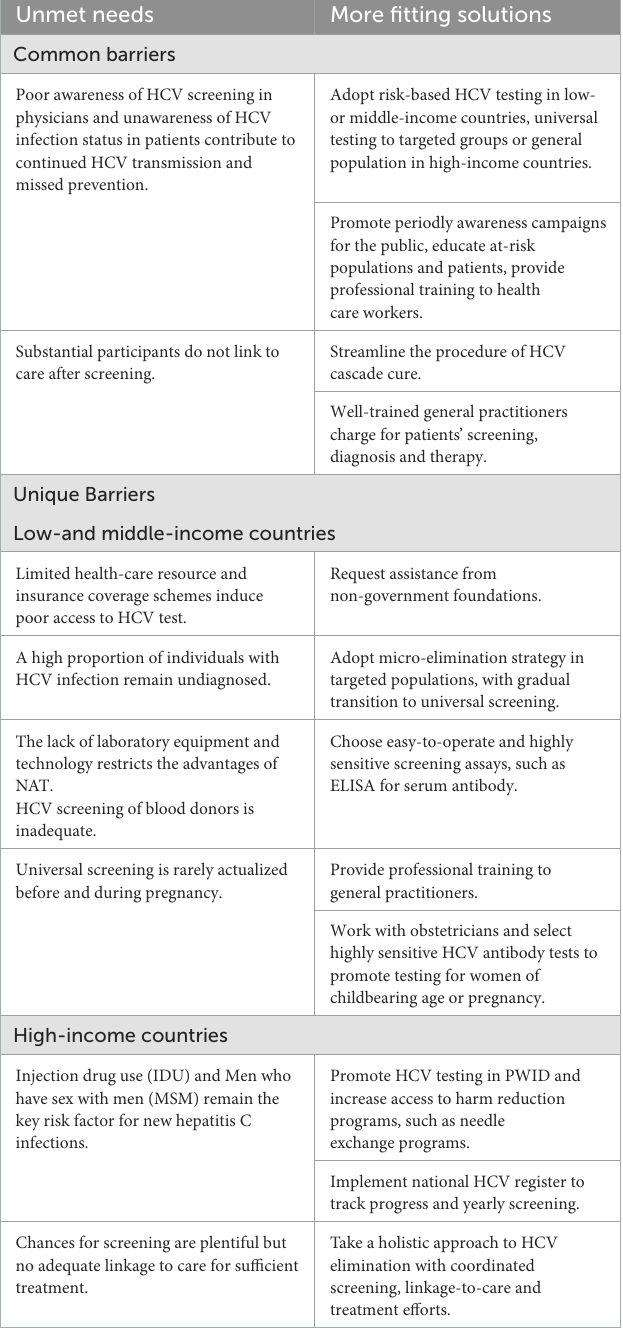
TABLE 1 The unmet needs and solutions to HCV screening management in countries of different incomes. Unmet